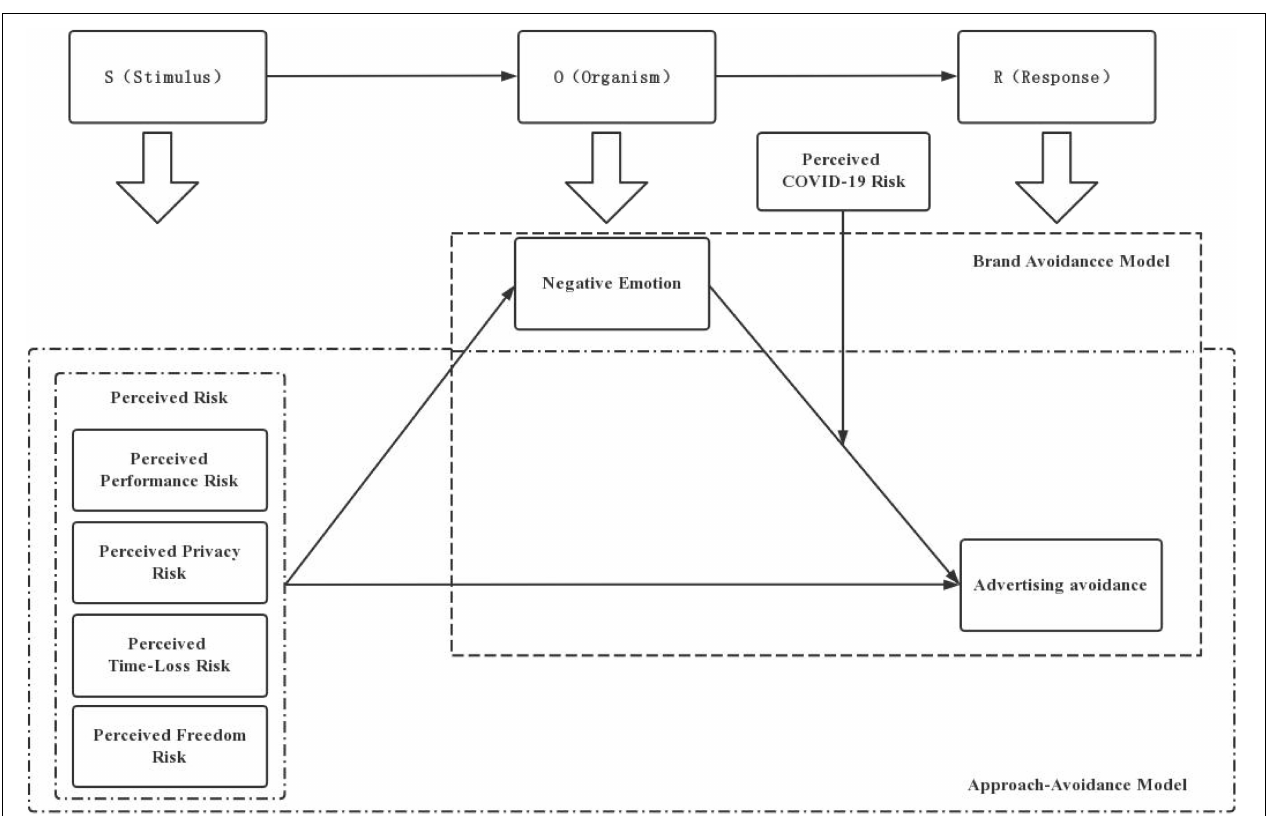
FIGURE 2 | Theoretical